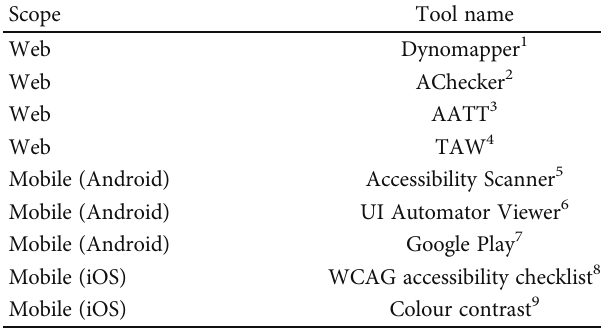
Table 2: Accessibility validation tools for